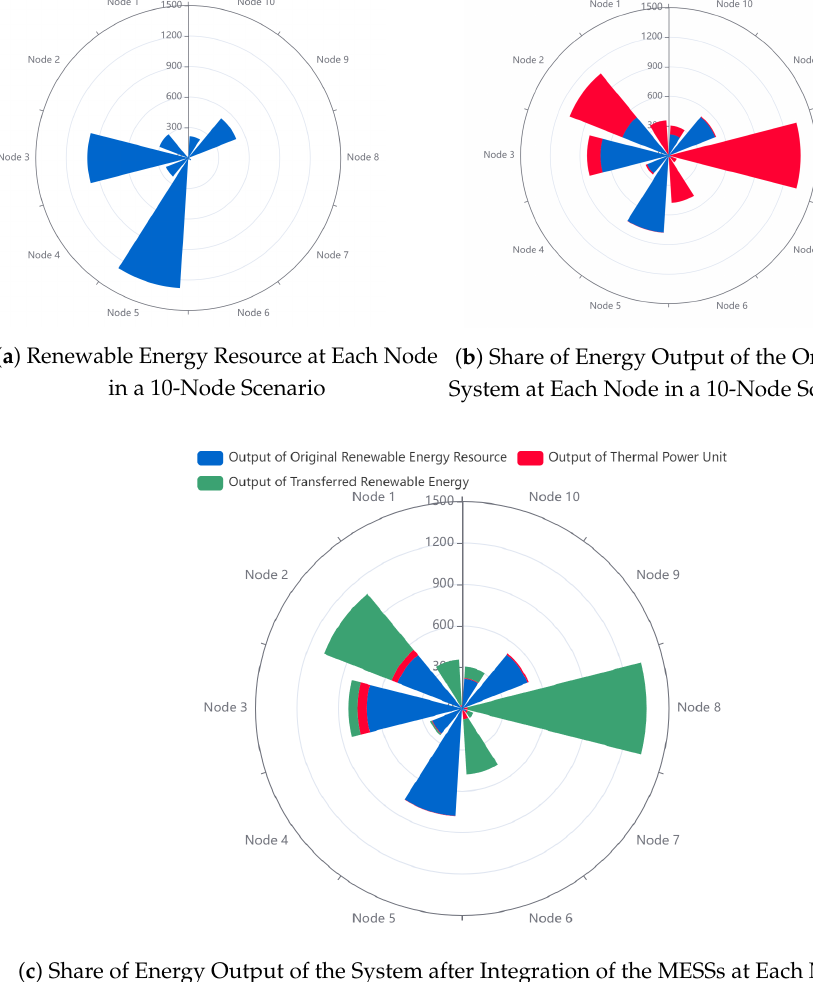
Figure 3. The Output of Thermal Power Units, Original Renewable Energy, and Transferred Renew- able Energy at Each Node in a 10-Node